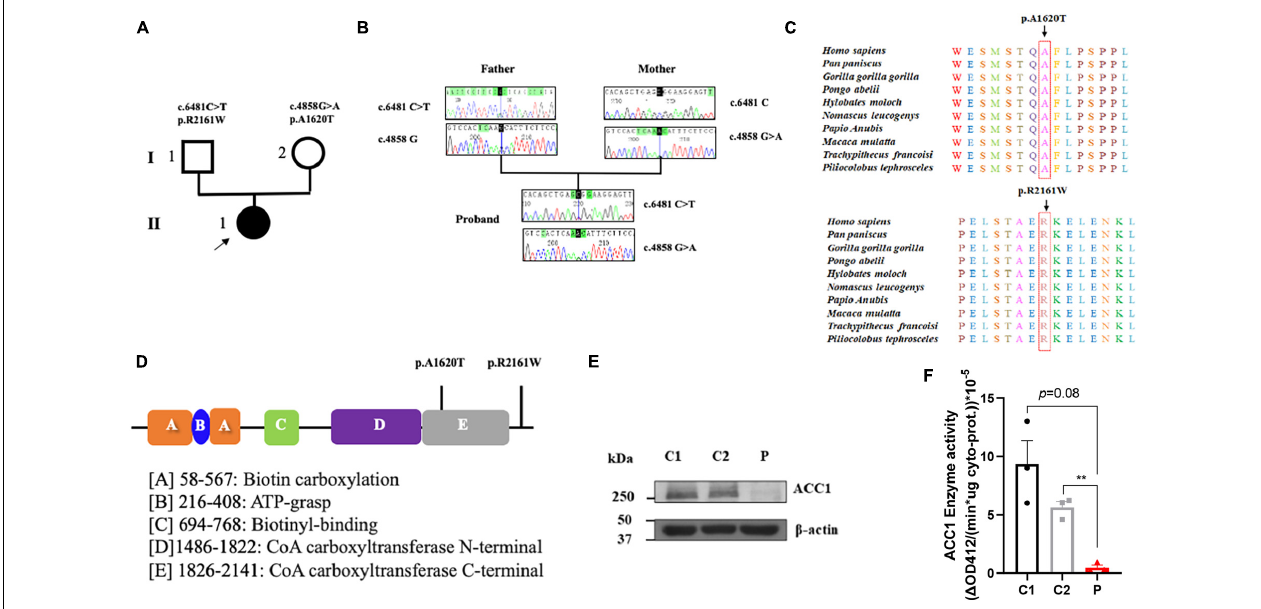
FIGURE 1 | Summary of the genetic characteristics and SDS-PAGE of ACC1 protein content and ACC1 enzyme activity. (A) The pedigree of the affected individual. The proband was represented as black solid circle and pointed out by an arrow. The square indicates male, and the circle female. (B) Sanger sequencing of the mutations. (C) The amino acid conservation among different species. (D) The functional domain of ACC1, and the mutation sites were marked. (E) Relative ACC1 protein content of lymphocytes. (F) The ACC1 enzyme activity among the proband- and age-matched control-derived lymphocytes. One-way ANOVA applied in panels (E,F) . ** p <